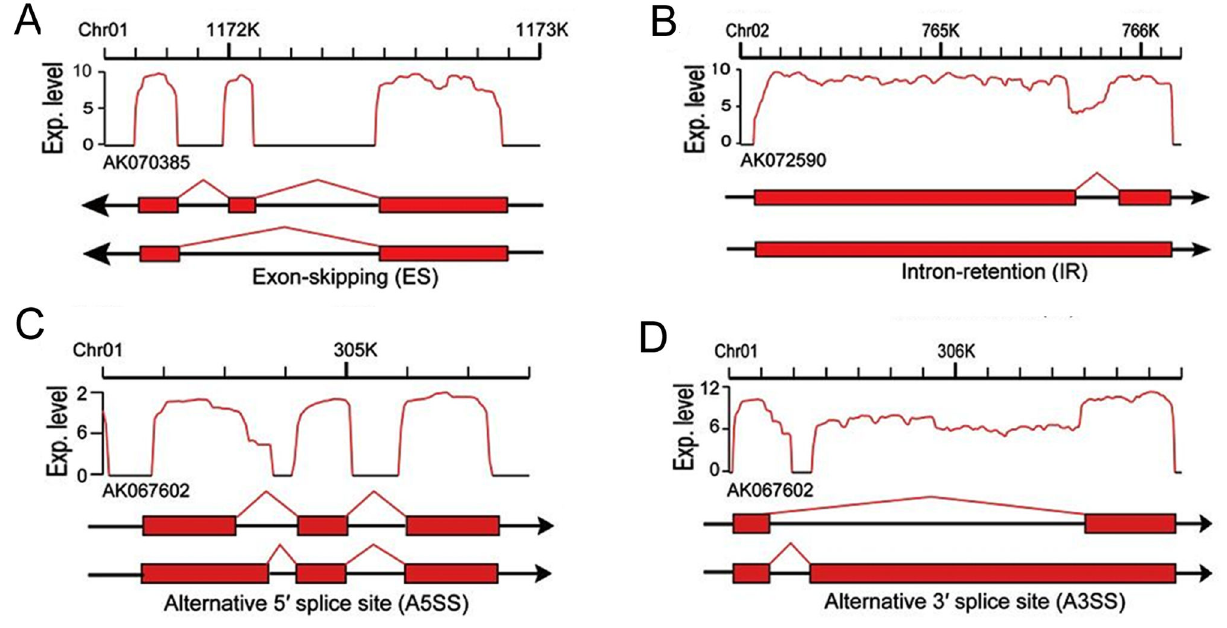
Figure 1. Sketch of alternative splicing in the ovine transcriptome. The schematic depicts the four primary types of AS events in the ovine transcriptome. The red curve indicates expression level (log the red line shows the linkage between two exons.